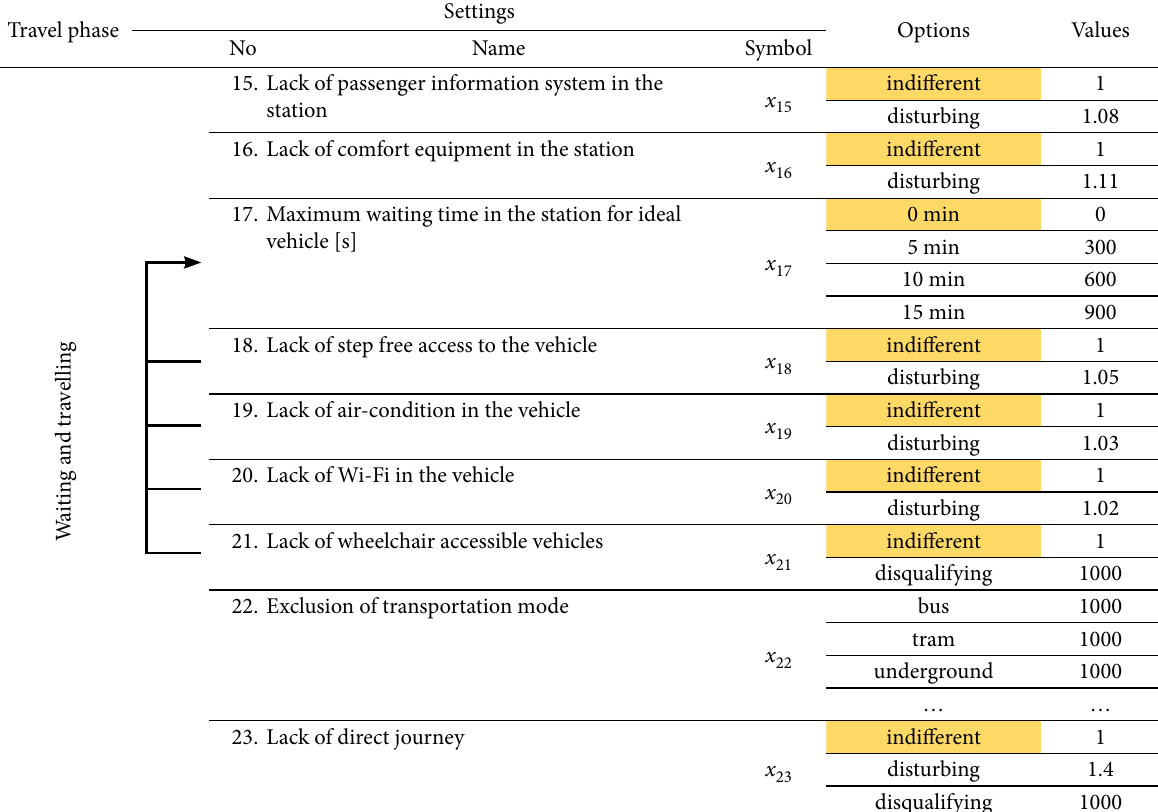
Table 7. Personalised setting options in the journey (waiting and travelling) phase (source: research by the authors) Travel